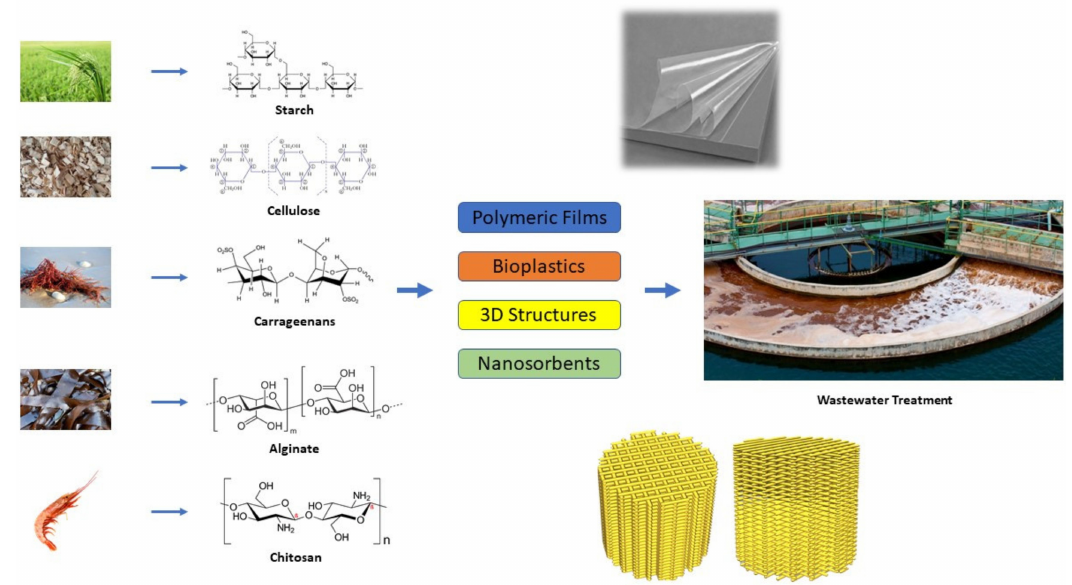
Figure 1. An overview of different approaches adopted in current biopolymer-based wastewater